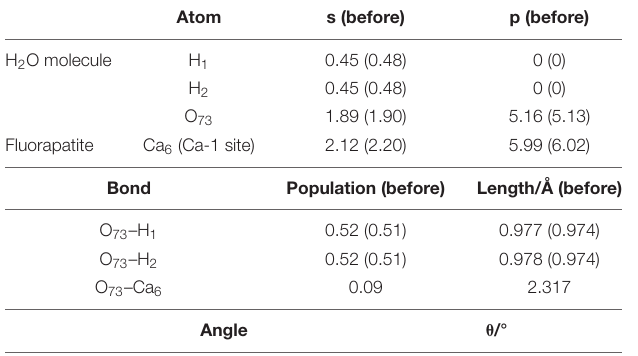
TABLE 1 | Charge transfer and bond properties of single-site adsorption.